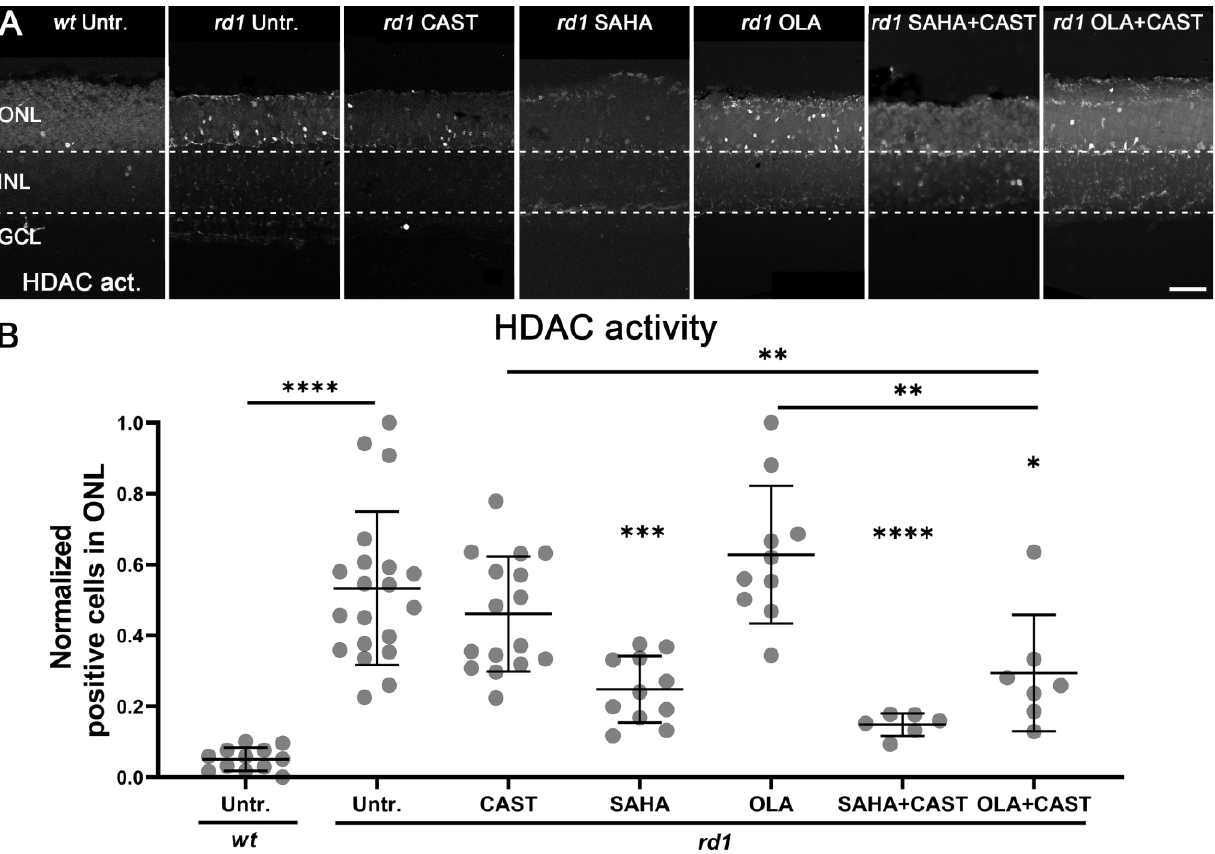
Figure 3. Effects of mono- and combination therapies on photoreceptor HDAC activity. ( A ) The retinal activity of HDACs was assessed using an in situ activity assay (grey). HDAC activity was strongly increased in the outer nuclear layer (ONL) of the untreated (Untr.) rd1 retina compared to the wild-type ( wt ). ( B ) Quantification of the numbers of HDAC activity-positive cells in the various experimental groups. Unsurprisingly, the HDAC inhibitor SAHA significantly reduced HDAC activity; however, HDAC activity was not decreased by either the calpain inhibitor CAST or the PARP inhibitor OLA. The combination of OLA and CAST had a minor effect on HDAC activity. Images shown represent at least six different specimens for each genotype. Untr. wt : 12 explants from 12 different mice; untr. rd1 : 20/20; CAST rd1 : 16/16; SAHA rd1 : 11/11; OLA rd1 : 10/10; SAHA + CAST rd1 : 6/6; OLA + CAST rd1 : 7/7; error bars represent SD; INL = inner nuclear layer; GCL = ganglion